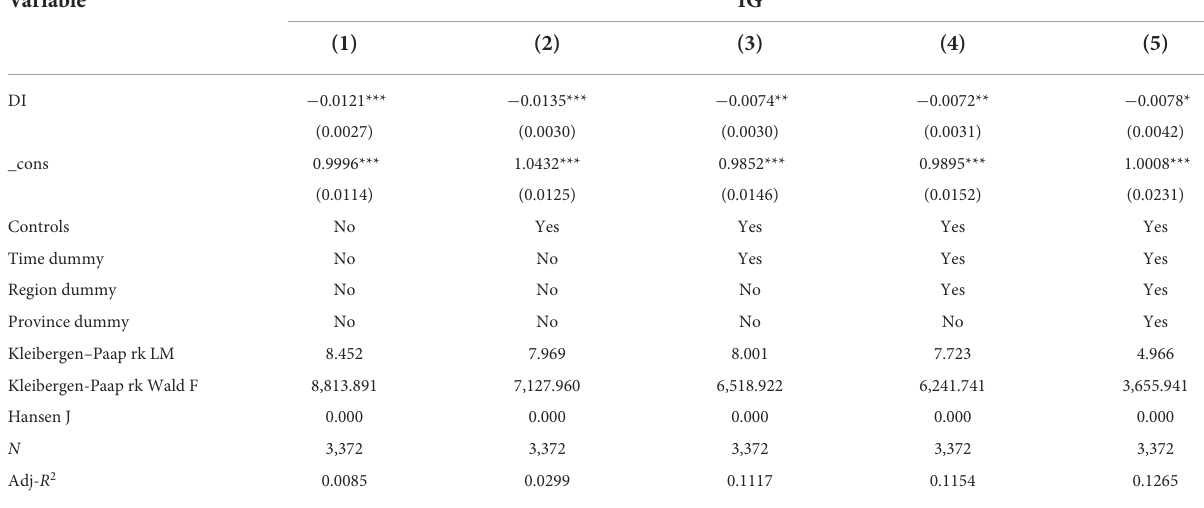
TABLE 2 Static effect analysis.